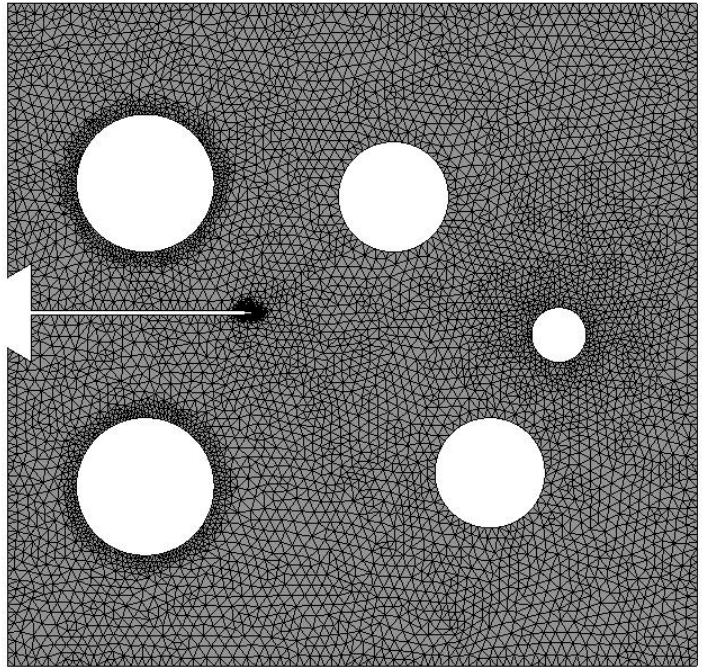
Figure 8. Initial adaptive mesh for the MCTS.